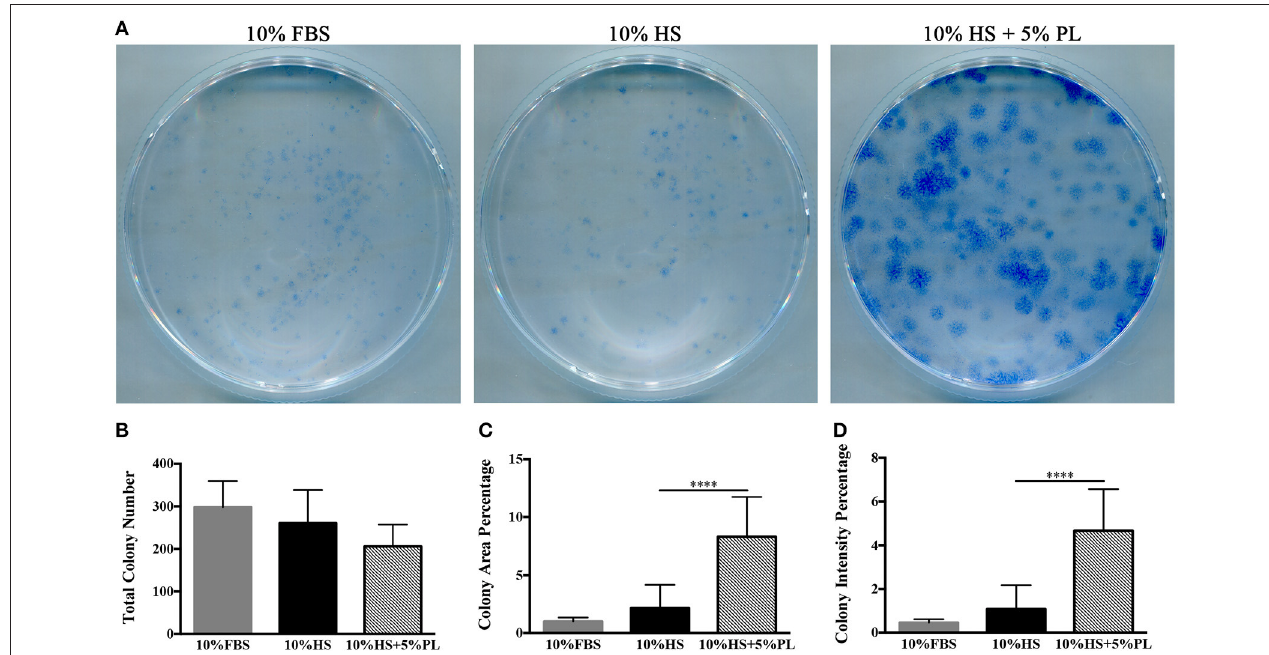
FIGURE 4 | CFE assay performed on hASC immediately after their isolation (passage 0) by using media supplemented with 10% FBS, 10% HS, or 10% HS + 5% PL. (A) Scans of methylene blue-stained colonies deriving from a representative experiment; (B) Number of colonies per condition counted by naked eye. Average values ± SD of 5 independent experiments, each one performed in duplicate; (C,D) “Colony area percentage” and “colony intensity percentage” calculated by ImageJ-plugin “ColonyArea.” Average values ± SD of 5 independent experiments, each one performed in duplicate. The **** symbol corresponds to p <